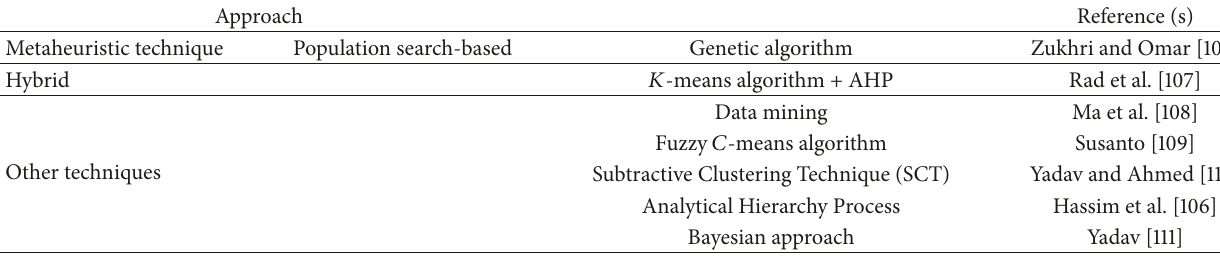
Table 15: Summary of studies related to NSAP